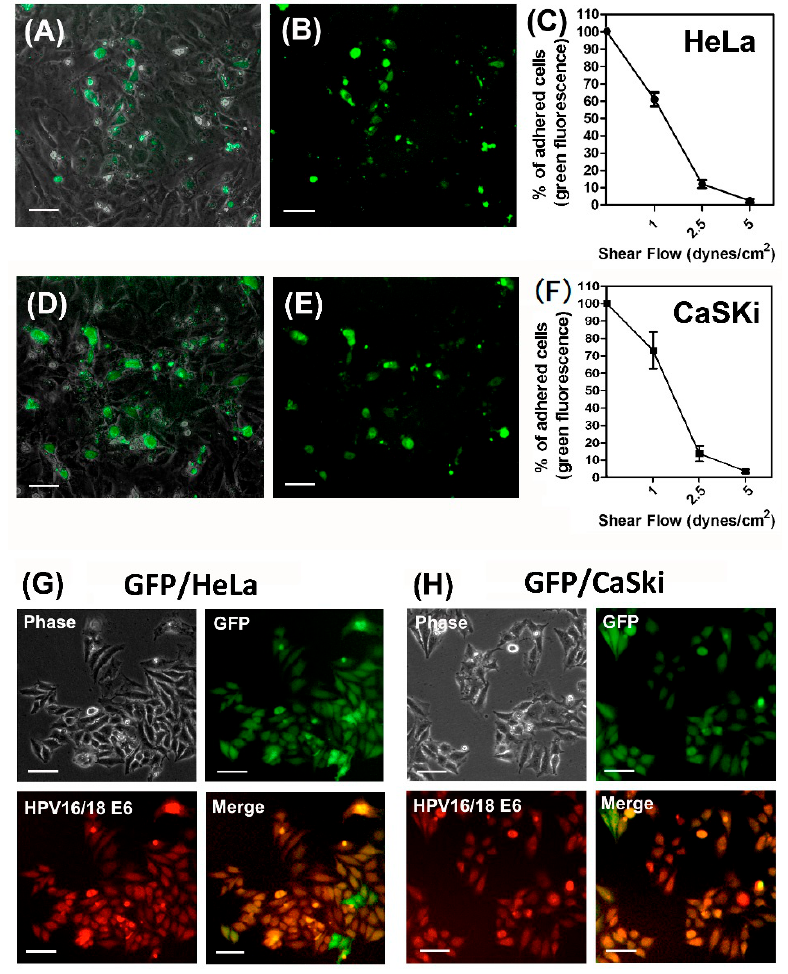
Figure 1. Establishment of a parallel-plate flow chamber system to simulate the in vivo dynamic flowing conditions for a selection of wild-type (WT) and shear stress-resistant (SSR) cervical cancer cell clones, and decreased expression of microRNA-128 ( miR-128 ) in the SSR group compared to the WT group. A parallel-plate flow chamber was assembled with a glass slide seeded on a monolayer of human umbilical cord vein endothelial cells (HUVECs) and suffused for 24 h with a medium for HUVECs; the various shear flow forces were generated and controlled using a peristaltic pump. ( A ) Representative microscopic images show that the GFP-expressed HeLa cells remained on the HUVEC layer after being exposed to 2.5 dynes/cm 2 shear forces for 10 min. ( B ) Viable GFP-expressed SSR-HeLa cells shown in green fluorescence. Scale bar, 100 µ m. ( C ) Summary of the ratio of adhered cells on the HUVEC layer after exposure to various shear flow forces. Consistent results are shown in ( D , E ); the viable GFP-expressed CaSki cells that adhered on the HUVEC layer were resistant to 2.5 dynes/cm 2 shear flow. The ratio of adhered CaSki cells on the endothelial cells was counted and summarized in ( F ). ( G ) Representative figures show the phase contrast (left upper panel) of GFP-expressed WT-HeLa cell populations indicated by a FACSAria™ III cell sorter. Isolated GFP-expressed HeLa cell populations are shown in green fluorescence (right upper panel) and HPV 16/18 E6-stained HeLa are shown in red fluorescence (left lower panel). The merged photographs (shown in yellow fluorescence; right lower panel) indicate that GFP-expressed HeLa cells co-expressed HPV 16/18 E6, a marker only shown on HeLa and CaSki cervical cells instead of in HUVECs. Similar results were found in isolated GFP-expressed SSR-CaSki cells, as shown in ( H ). Scale bar, 100 µ m. This implies that our isolated GFP-expressed HeLa and CaSki cells clones were free of contamination from HUVECs.